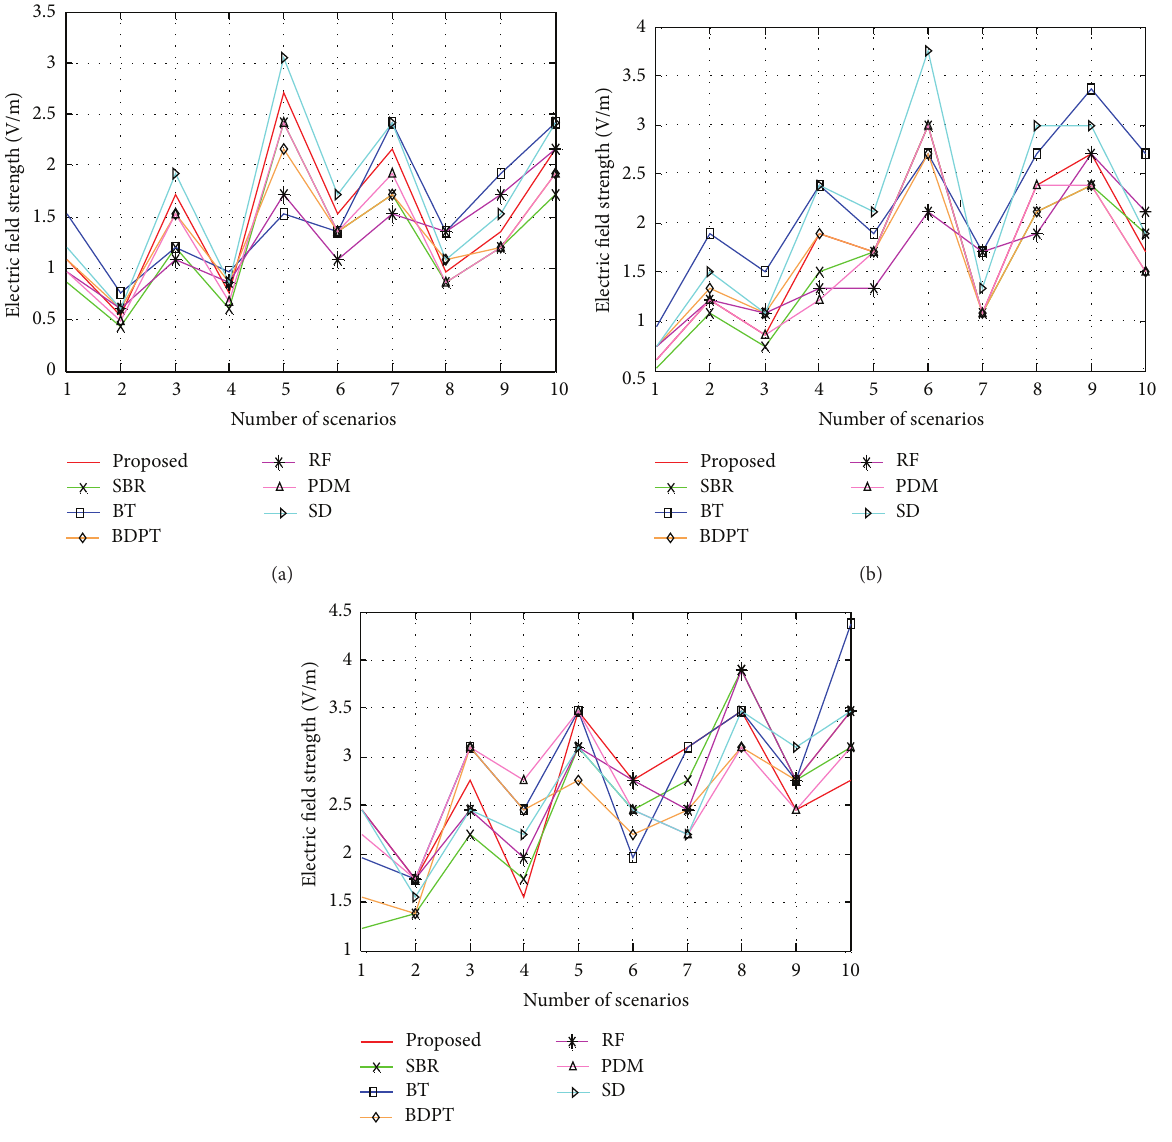
Figure 12: Electric field strength with (a) half wave dipole antenna, (b) bow-tie antenna, and (c) hemispherical